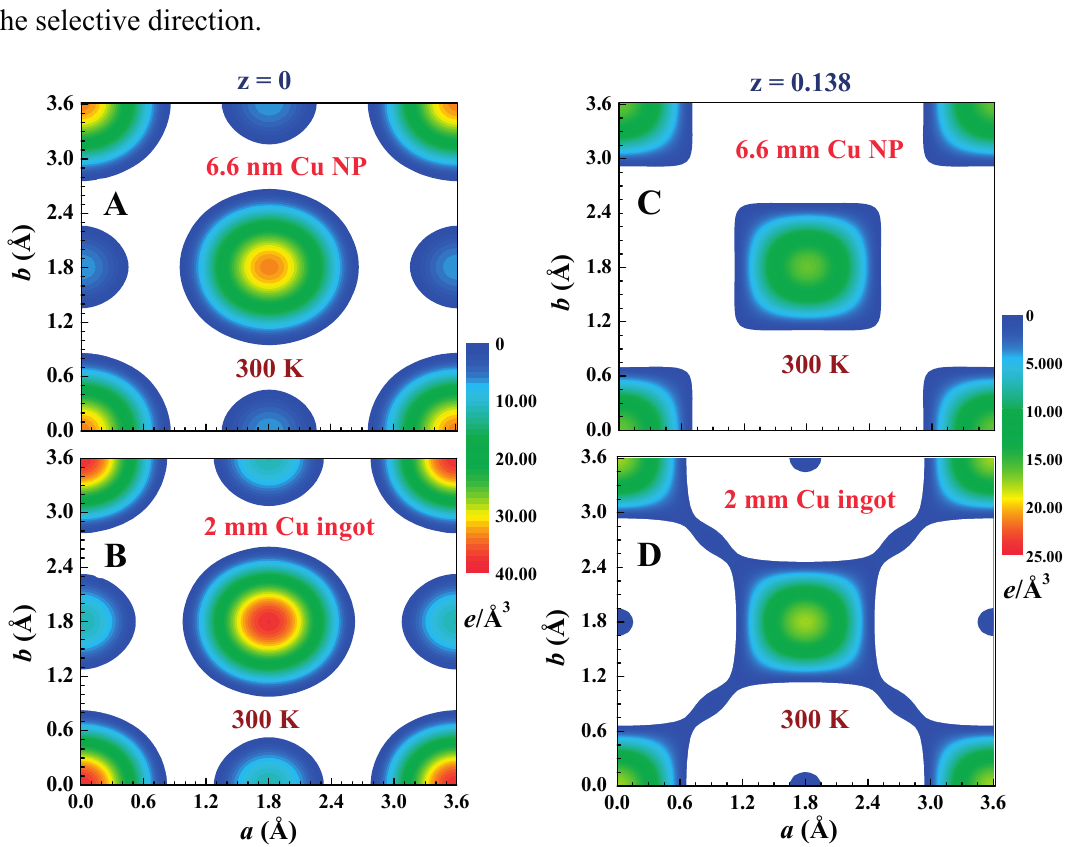
Figure 4. ( A , B ) Electronic charge densities in the z = 0 crystallographic plane of the 6.6 nm Cu nanoparticles and 2 mm Cu ingot, as inferred from the X-ray diffraction data; and ( C , D ) electronic charge densities in the z = 0.138 crystallographic plane of the 6.6 nm Cu nanoparticles and 2 mm Cu ingot. The color bars are in units of e /Å 3